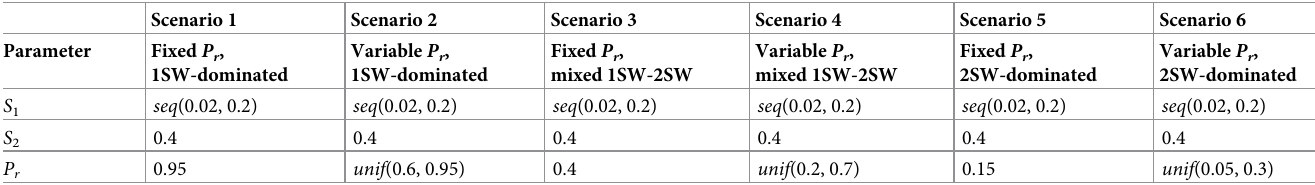
Table 1. Parameters used to simulate time series data of Atlantic salmon in the six